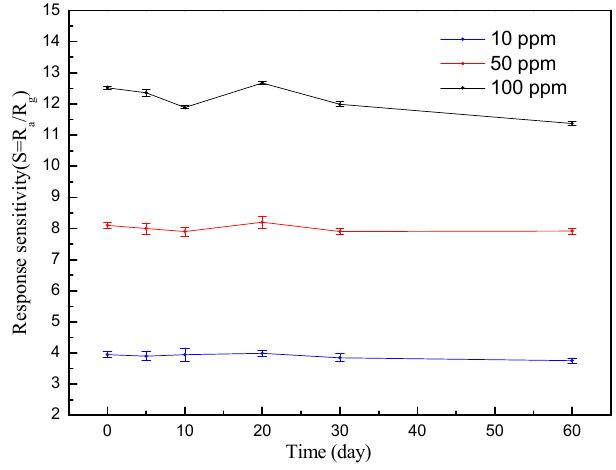
Figure 9. Long-term stability of the SnO 2 /ZnO sensor tested over two months.